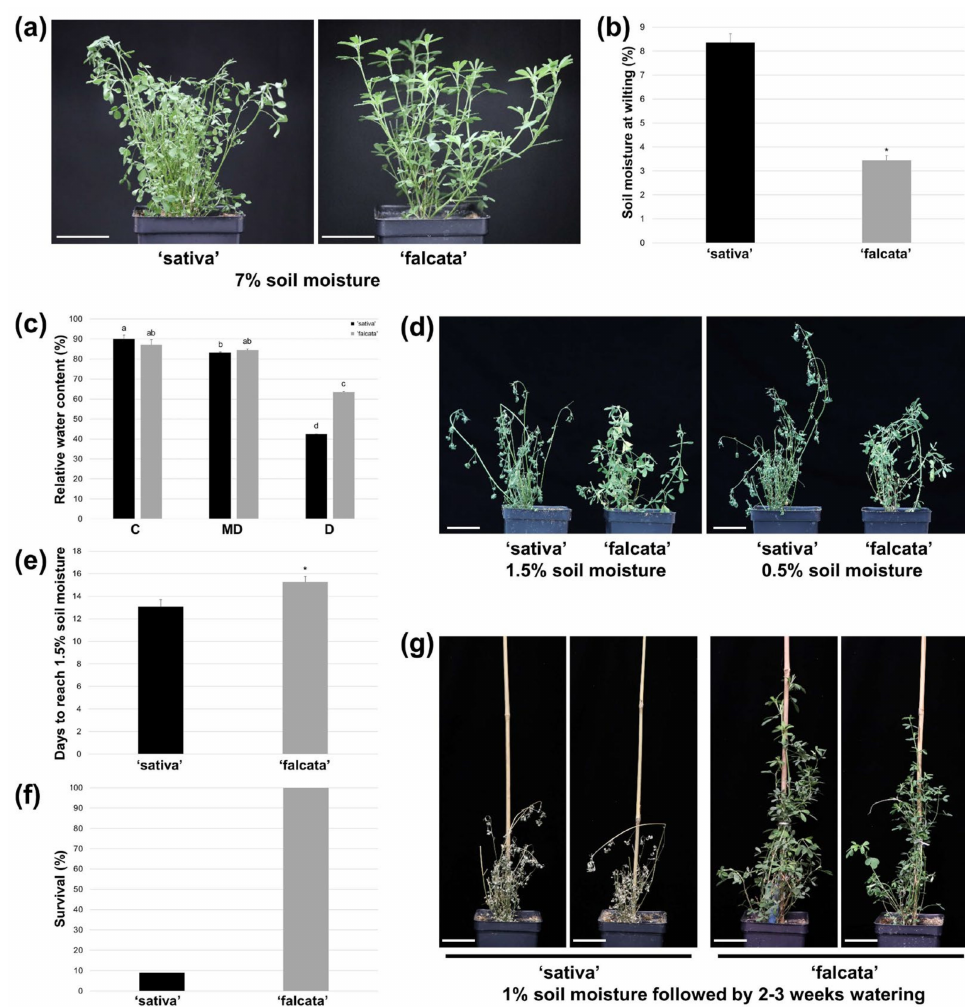
Figure 1. Response of ‘sativa’ and ‘falcata’ genotypes to drought stress conditions. ( a ) Representative images of ‘sativa’ and ‘falcata’ after withholding water until volumetric soil moisture levels reached approximately 7%. ( b ) Soil moisture level at which ‘sativa’ and ‘falcata’ began to wilt. ( c ) Relative water content (RWC) of first fully expanded trifoliate leaves assessed when soil moisture contents were at ~50% (C, control), ~20% (MD, mild drought), and ~7% (D, drought). ( d ) Representative images of ‘sativa’ and ‘falcata’ after withholding water until soil moisture levels reached 1.5% and 0.5%, respectively. ( e ) Number of days from the initiation of drought treatment at which soil moisture levels in pots reached approximately 1.5%. ( f ) Proportion of plants that survived following 2–3 weeks of re-watering after allowing soil moisture contents to reach 1%. ( g ) Representative images of ‘sativa’ and ‘falcata’ plants following 2–3 weeks of re-watering once plants reached 1% soil moisture content. Blocks in each graph consist of the mean value of 10 ( e ) or 11 ( b , c , f ) biological replicates derived from vegetative stem cuttings, with black denoting ‘sativa’ and gray denoting ‘falcata’. Bars denote standard errors. Scale bars = 5 cm. Lowercase letters indicate statistically significant differences between groups in each graph ( p ≤ 0.05), while asterisks denote means that are statistically different in ‘falcata’ compared to ‘sativa’ ( p ≤